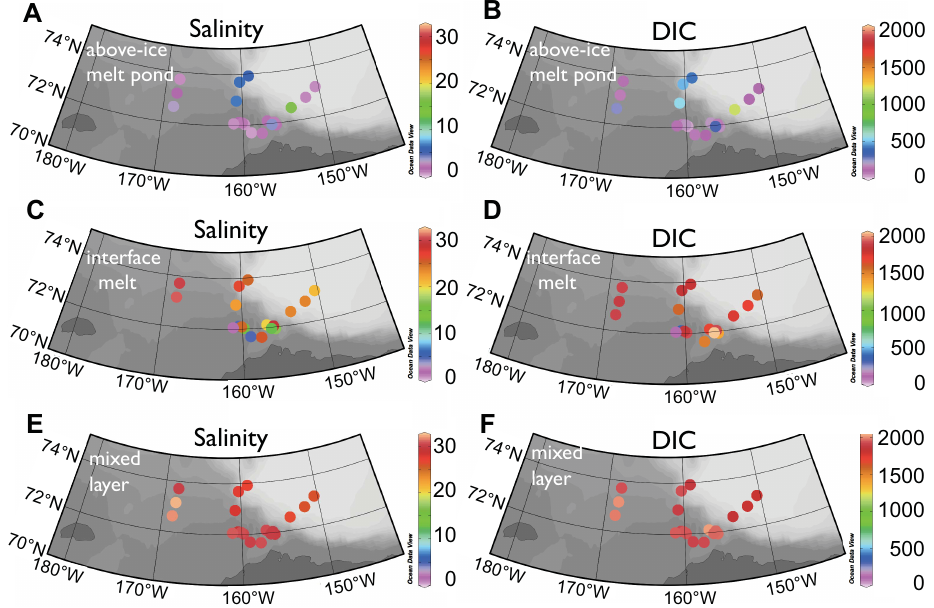
Figure 4. Surface maps of above-ice melt ponds, below-ice interface melt water, and mixed-layer values beneath each ice station sampled on 2010 and 2011 ICESCAPE cruises. (a) Salinity for above-ice melt ponds. (b) DIC (µmolkg − 1 ) for above-ice melt ponds. (c) Salinity for below-ice interface melt water. (d) DIC (µmolkg − 1 ) for below-ice interface melt water. (e) Salinity for mixed-layer values beneath each ice station. (f) DIC (µmolkg − 1 ) for mixed-layer values beneath each ice station. Similar panels are shown for TA in Fig.